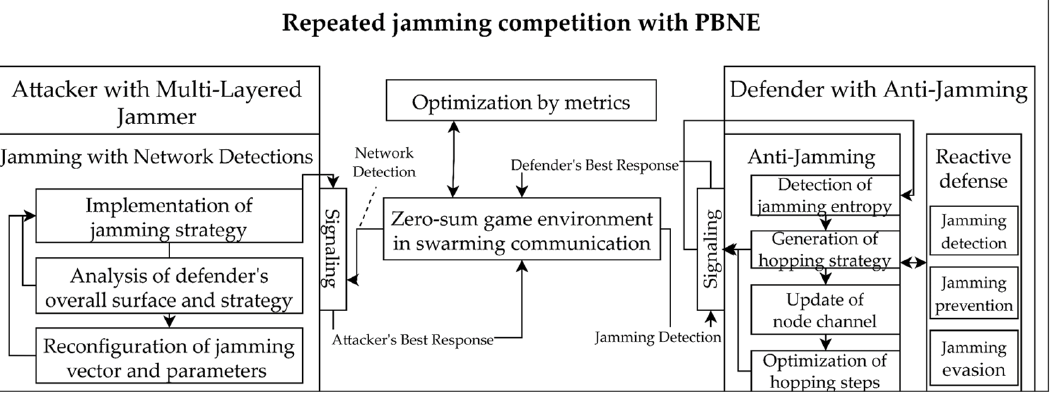
Figure 2. Detailed sub-overview of the zero-sum-based dynamic cyber-electronic warfare competition with PBNE (perfect Bayesian–Nash equilibrium) in jamming threat from D-CEWS.